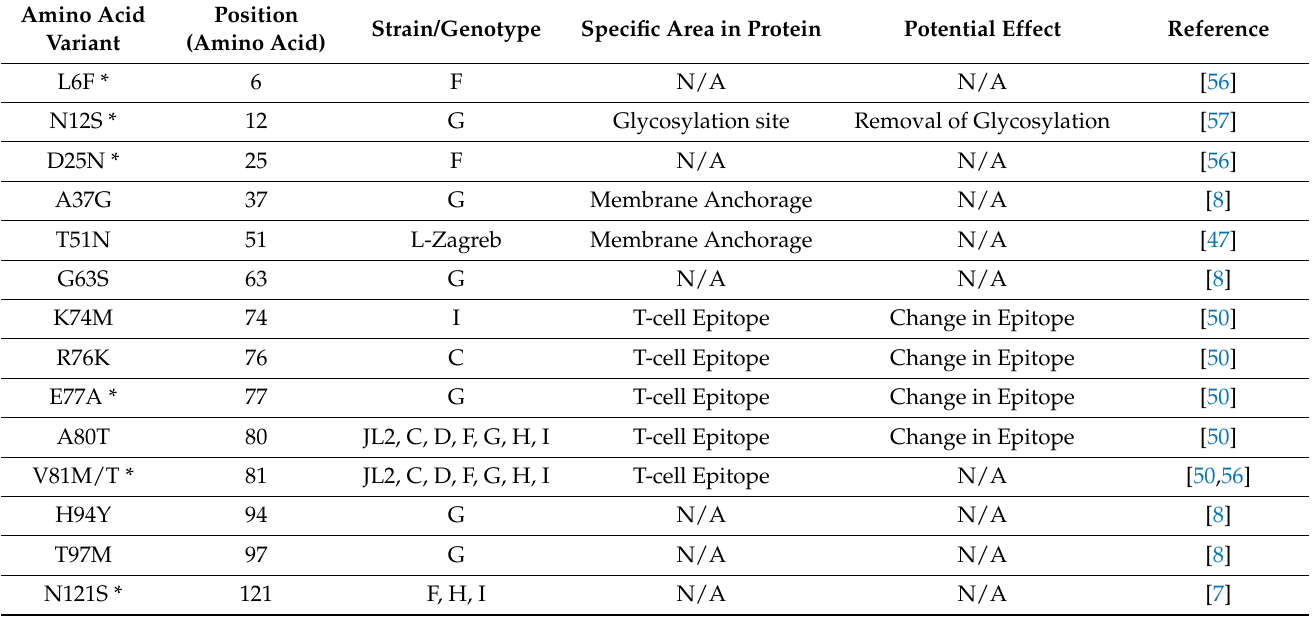
Table 2. Currently known HN amino acid variants in wild-type viruses when compared to vaccine